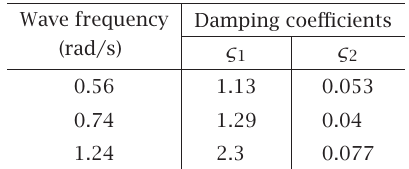
Table 6.1 . Computed damping